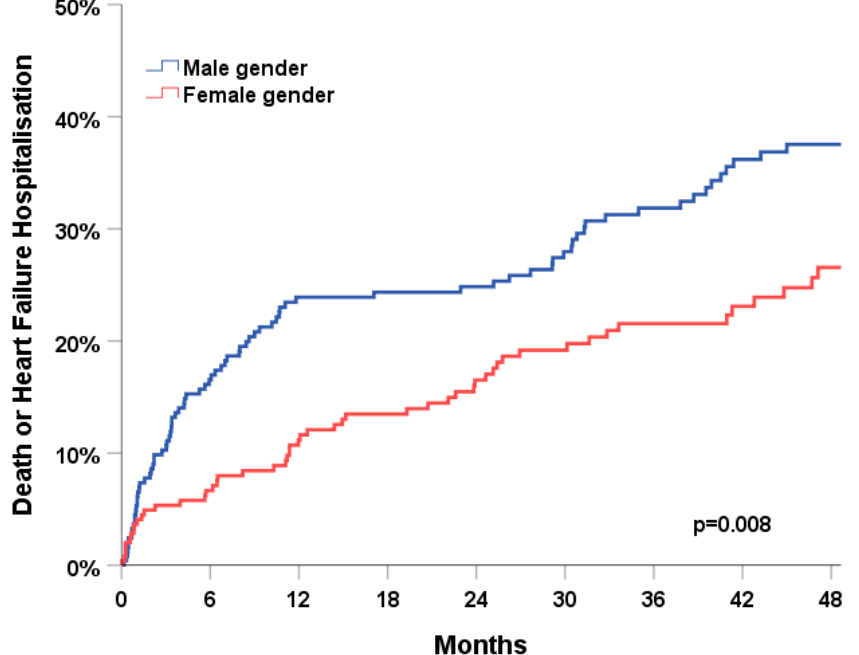
Figure 1. Association of sex category with the combined clinical endpoint of all-cause death or heart failure hospitalisation during 4 years of follow-up.